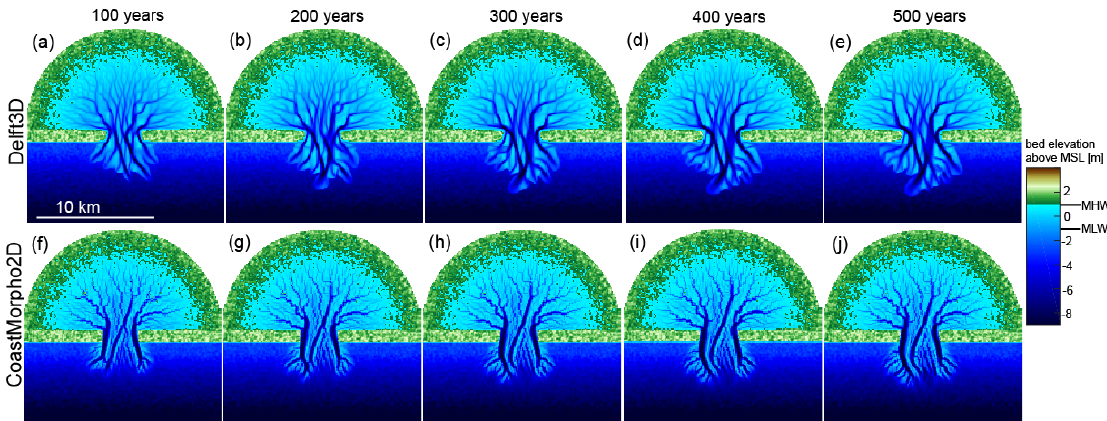
Figure 5. Reference simulations with Delft3D and with CM2D with best fit parameters. ( a – e ) Delft3D, plotted every 100 years; ( f – j ) CM2D, plotted every 100 years.